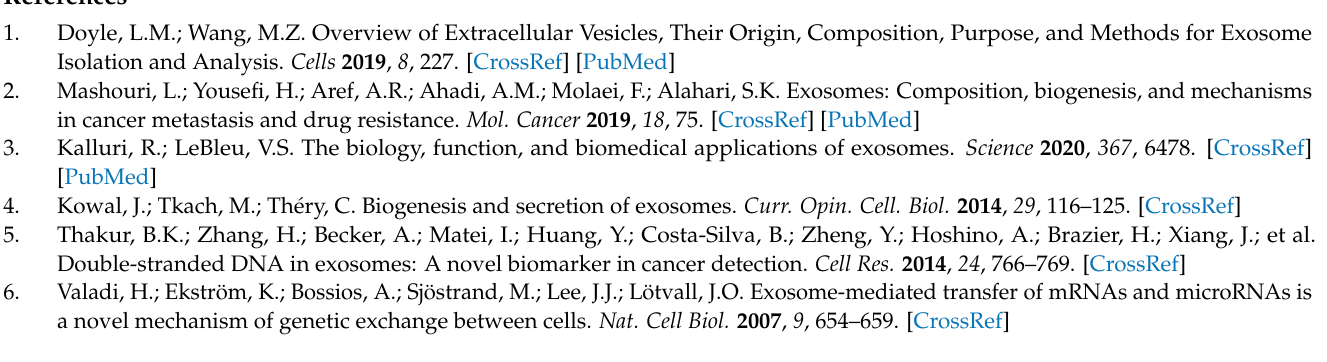
Table S2: Main characteristics of the cell lines included in the study; Table S3: List of antibodies TaqMan ® Gene Expression Assays used in gene expression analyses; Table S5: Molecular alterations detected in cell culture-derived exosomes with different histologies; Table S6: Enrichment analysis